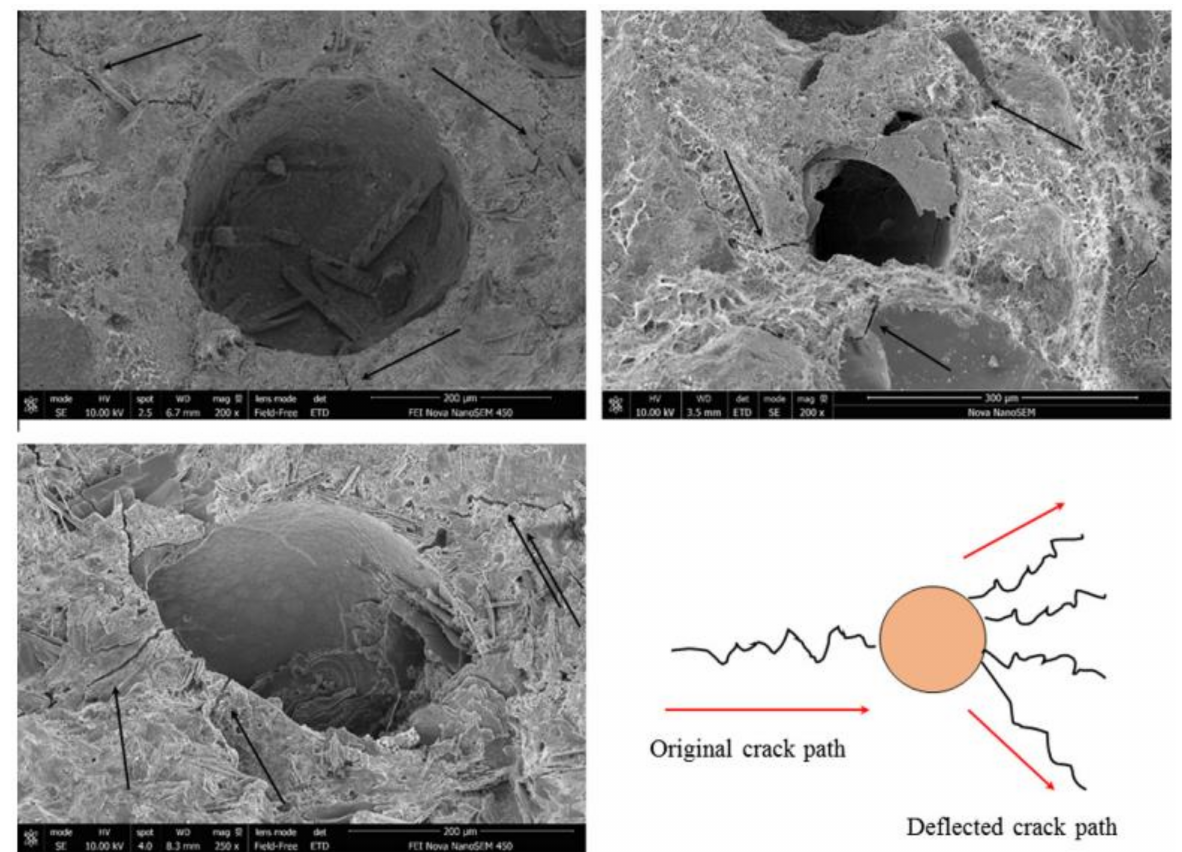
Figure 14. SEM images showing the crack propagation and deflection pattern around the microcap- sules (Adapted with permission from Elsevier